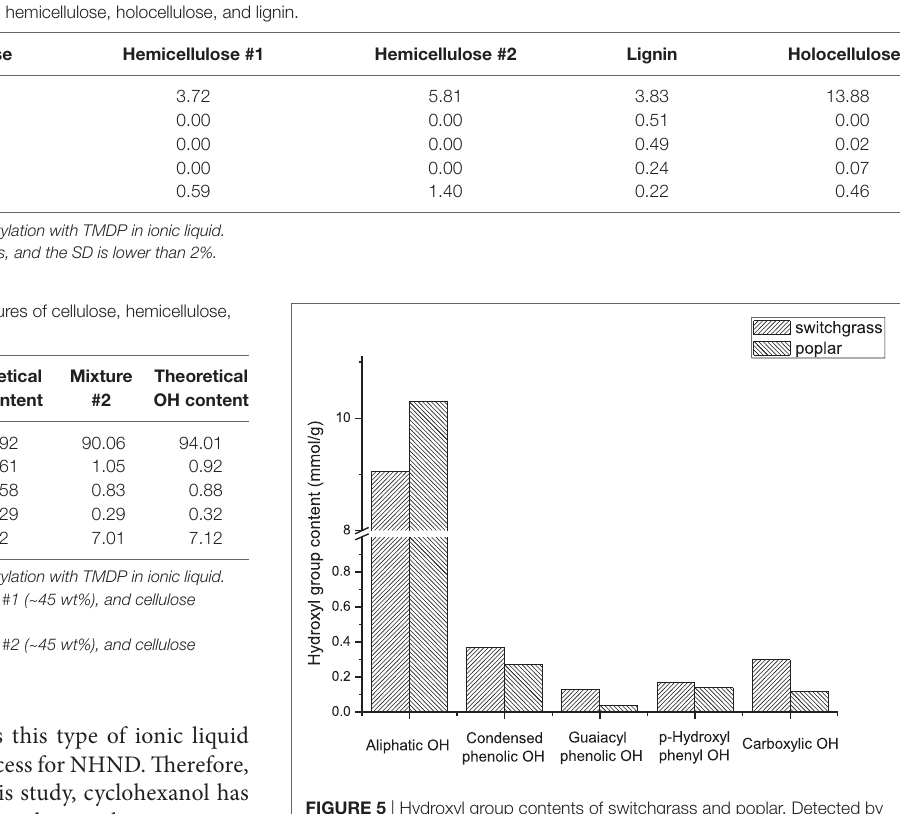
FigUre 5 | Hydroxyl group contents of switchgrass and poplar. Detected by 31 P NMR after dissolution and phosphitylation with TMDP in ionic liquid. (Due to the possible overlap and shift, the content of syringyl type OH is only a preliminary number. There were ~65% of C5 substituted/condensed phenolic OH in poplar belong to syringyl OH, and there were ~40% of C5 substituted/ condensed phenolic OH in switchgrass belong to syringyl